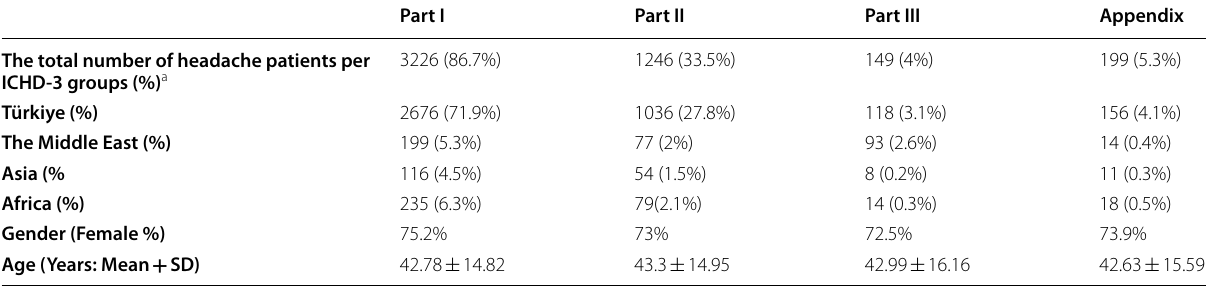
Table 1 Distribution and clinical characteristics of headache according to Part I‑II‑III and Appendix categories in